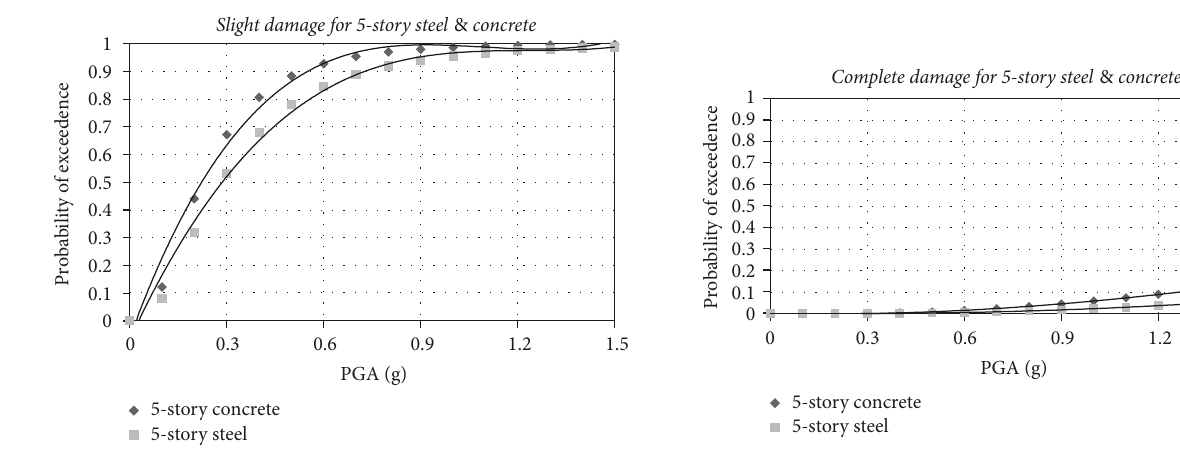
Figure 13: Comparison of the fragility of the 5-story steel and RC frame buildings for the extensive damage state.